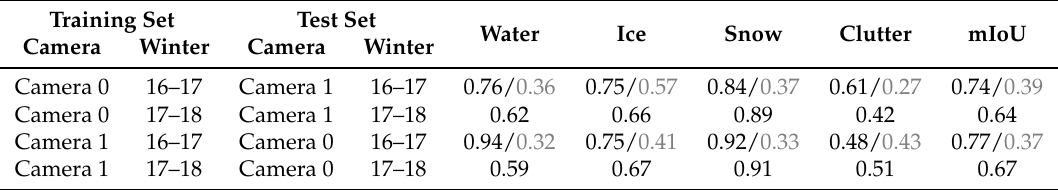
Table 17. Results (IoU) of cross-camera experiments. We compare our results with the Tiramisu Network [34] (shown in grey). Both cameras 0 and 1 monitor lake St. Moritz.